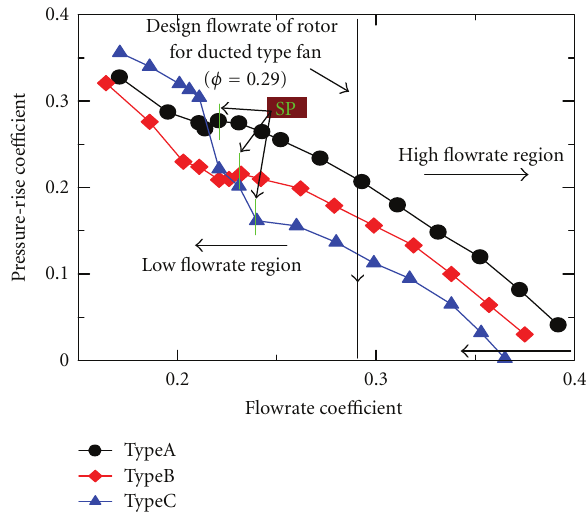
Figure 5: Pressure-flowrate characteristics for 3 types of